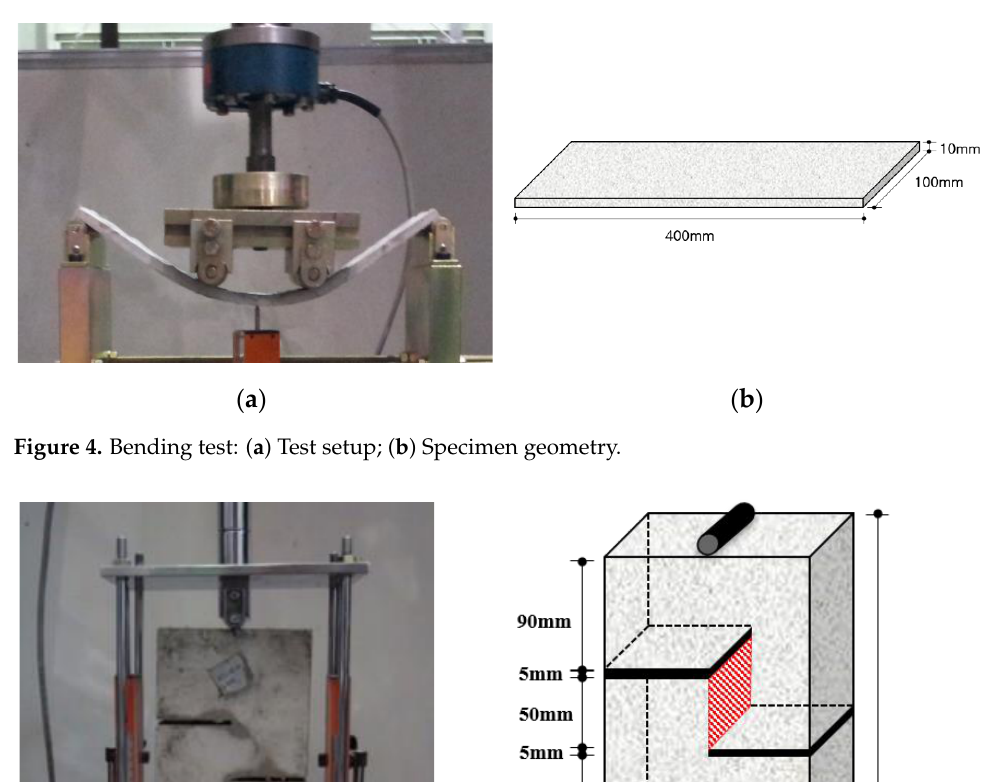
Figure 3. Direct uniaxial Tensile test: ( a ) Test setup; ( b ) Specimen geometry.